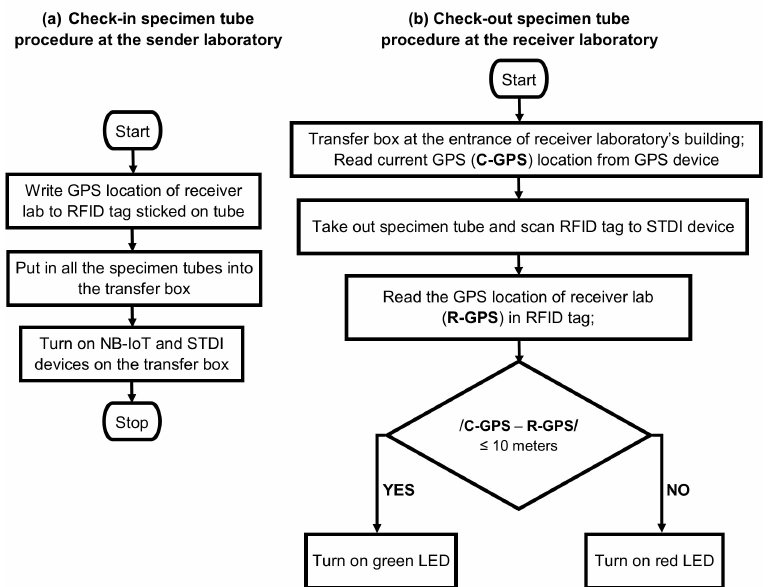
Figure 9. The check-in and check-out specimen tube